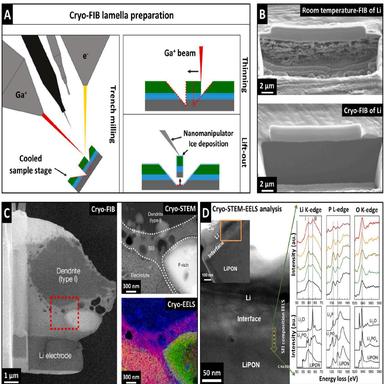
(A) Schematic illustration of the lamella preparation with a cryogenic SEM/FIB, adapted with permission from Ref.. (B) SEM images of metallic lithium cross-sectioned and cleaned by FIB at room temperature (top) and cryogenic temperature (bottom); adapted with permission from Ref., Copyright 2019 American Chemical Society. (C) SEM micrograph of the preparation of a liquid-solid interface lamella of lithium metal and the vitrified liquid electrolyte (left) and the corresponding cryo-